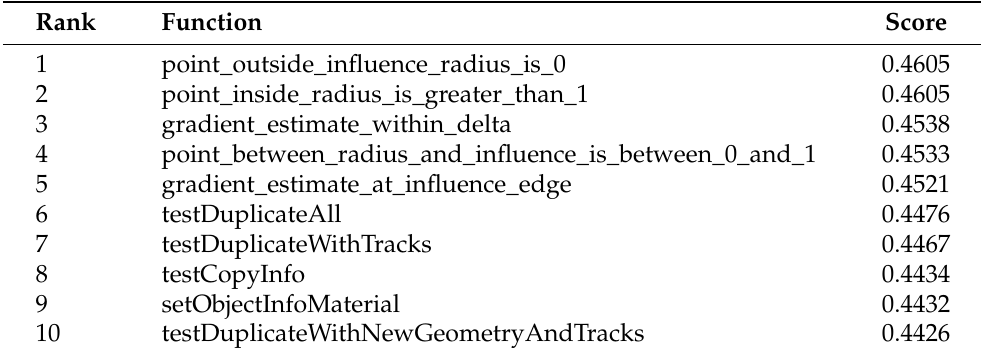
Table 6. Top-10 of results of ranking test cases based on the random forest model. Function is the name of a test case. Score is the average probability that a test case is identified in the model. A higher value indicates that the test case is more likely to trigger a